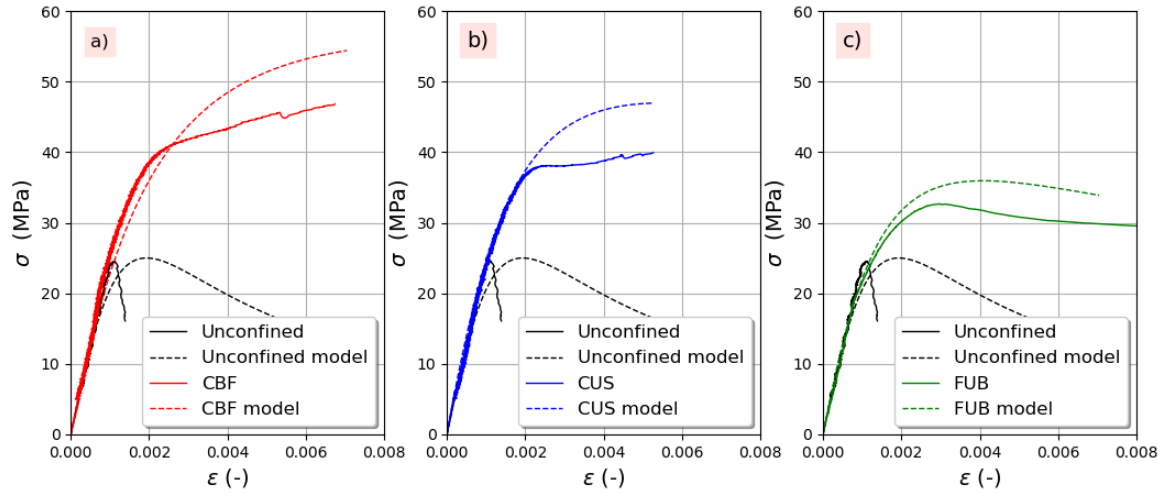
Figure 14. Experimental versus predicted stress–strain curves for concrete with 4% air-entraining agent: ( a ) CBF, ( b ) CUS, ( c ) FUB.4. Conclusions